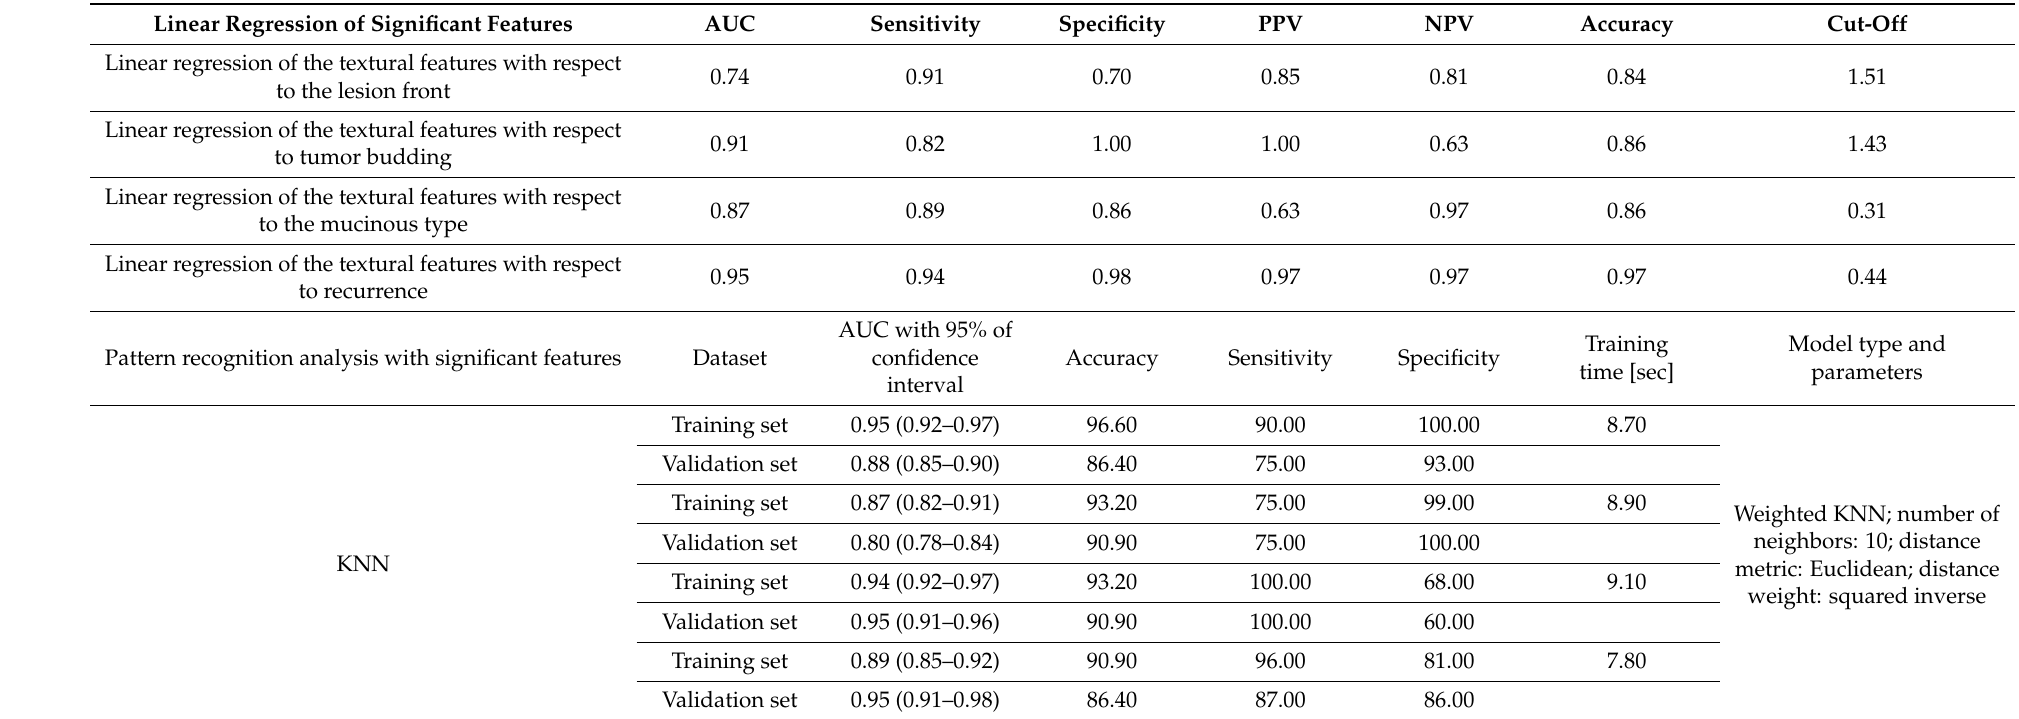
Table 4. Linear regression and pattern recognition analysis with significant features from the portal